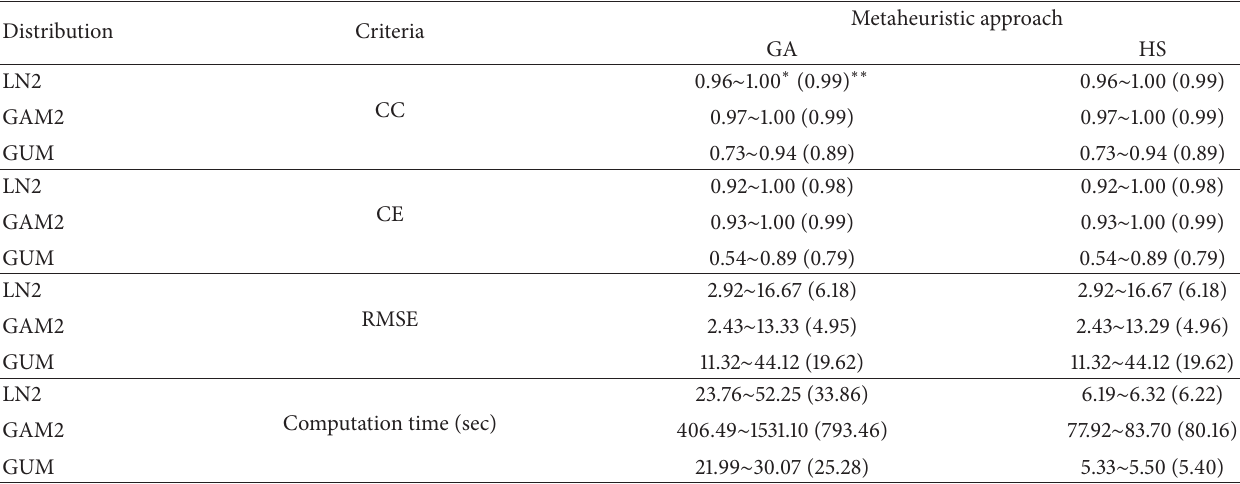
Table 3: Comparison of test criteria for the three